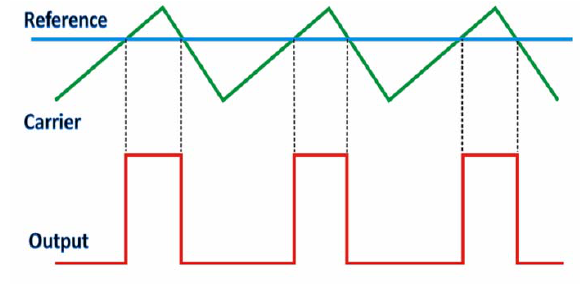
Figure 7. Outputsignal from the modulator: CC-CC Converter